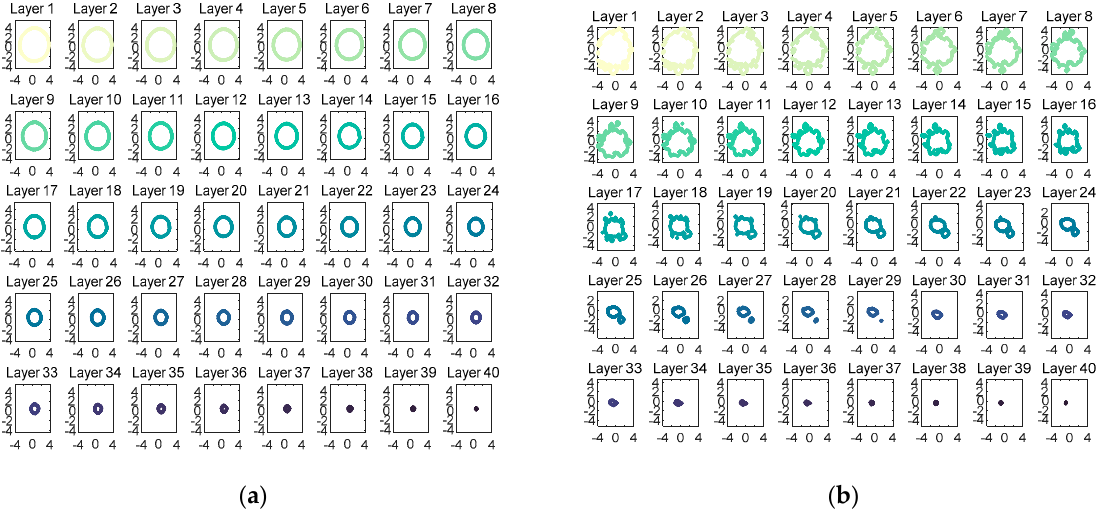
Figure 9. ( a ) All contours for a Class 0 milk powder sample; ( b ) all contours for a Class 3 milk powder sample.